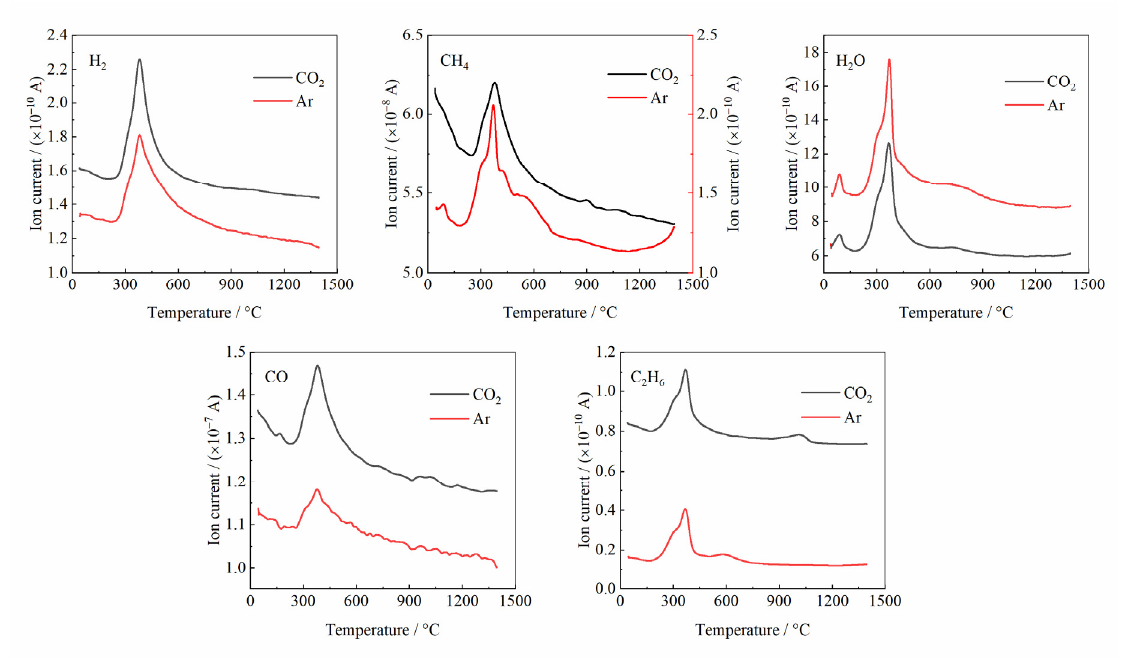
Figure 2. The variation of each light component at heating rate of 10 °C/min under CO 2 and Ar.